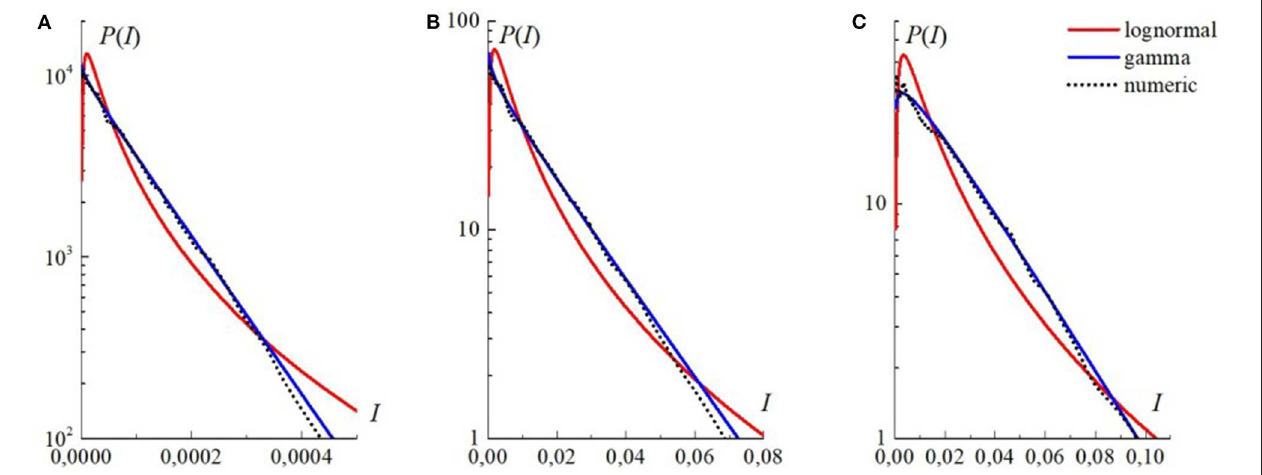
FIGURE 14 | Probability density distribution: (A) at the axis ( r 0) of the Laguerre—Gaussian beam; (B) at the periphery (at the point r = (C) at the axis ( r 0) of the synthesized vortex beam with the unit topological charge and N a 36. The values of σ I ( r ) are 1.04, 1.02, and 0.95, respectively. The path = = length z 0.1 z d , and the Rytov parameter β 2 0 0.1. Dots correspond to the lognormal distribution density [30], dashed curves are drawn by the equation of the = = gamma distribution